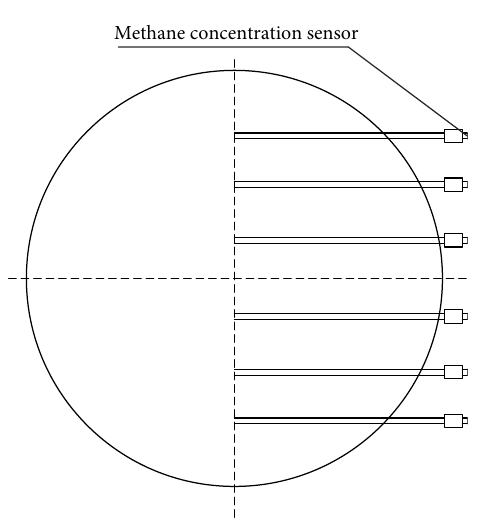
Figure 18: Layout of gas uniformity measuring points of gas mixing